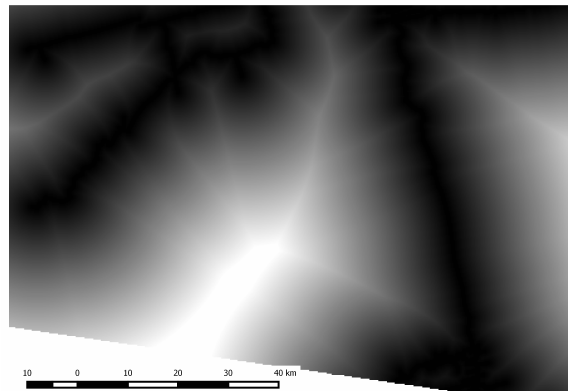
Figure 7: Map of distance from roads used as explanatory vari- able